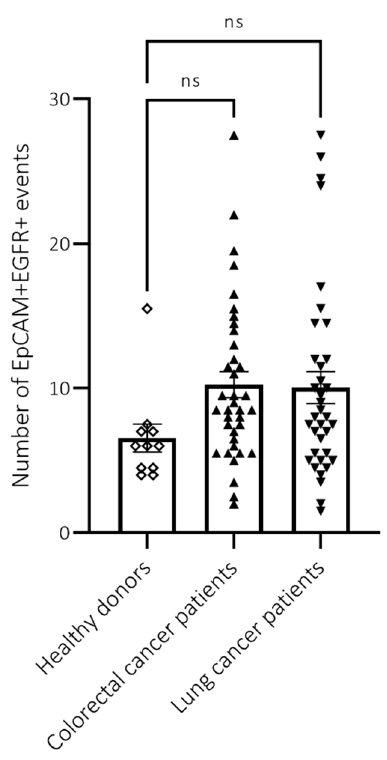
Figure 4. Cancer patients have increased numbers of EpCAM+EGFR+ cells in their circulation. Blood analysis of healthy donors ( ♦ ), colorectal cancer patients ( ) and lung cancer patients ( ). After PBMC isolation, samples were stained for EpCAM and EGFR, and analyzed using the Attune NxT. CTCs were detected by EpCAM+EGFR staining. p = 0.05.